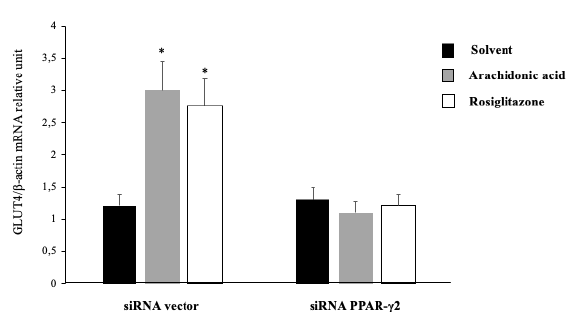
Figure 3. GLUT4 mRNA expression in HepG2 cells after PPAR- γ 2 gene silencing by siRNA. The mRNA expression of GLUT4 in HepG2 cells were determined by qRT-PCR, which were serum deprived for 16 h and transfected with PPAR γ -2-specific siRNA or control siRNA, followed by incubation with 10 µ M of solvent (DMSO) as a negative control, AA, and rosiglitazone as positive control for 48 h. The expression was normalized to β -actin. The columns represent means ± SEM of at least three experiments, and the data were analyzed by Student’s t test (* p < 0.05 denote significant differences compared with the vehicle). Abbreviations: GLUT4: glucose transporter type 4; PPARγ-2: